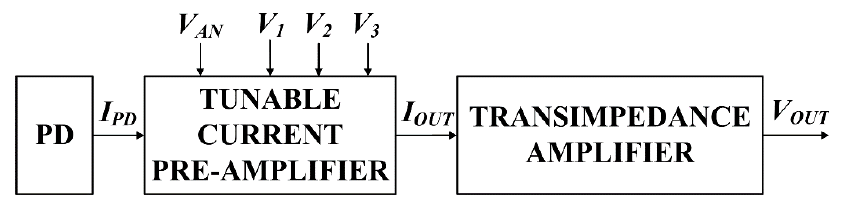
Figure 1. Overall block scheme of the proposed electronic circuit.